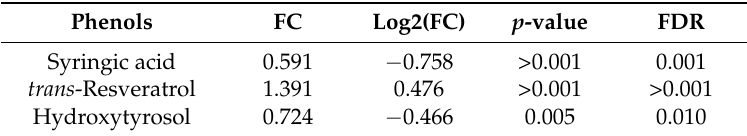
Table 2. Important phenols identified by fold-change analysis and t -test in Negroamaro and Primitivo wines. FDR: false discovery rate.